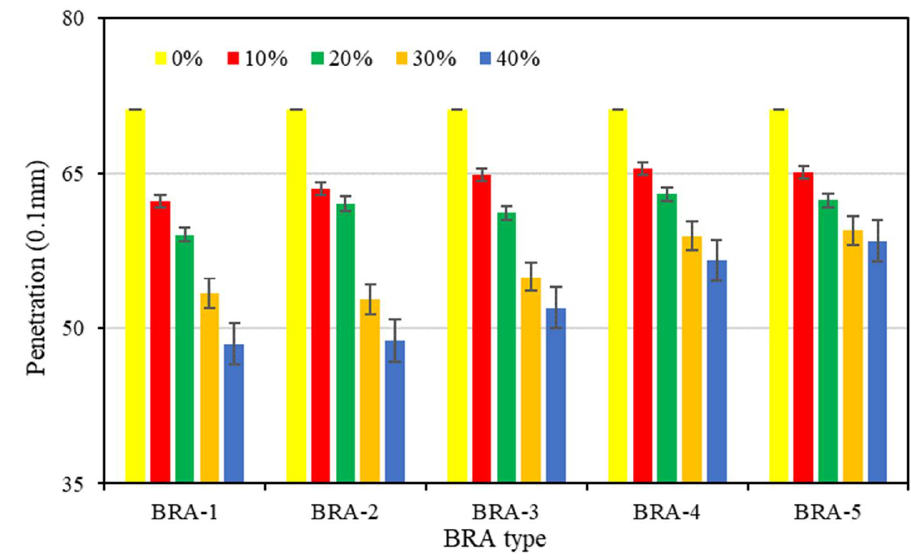
Figure 7. Penetration of base asphalt and BRA-MA.